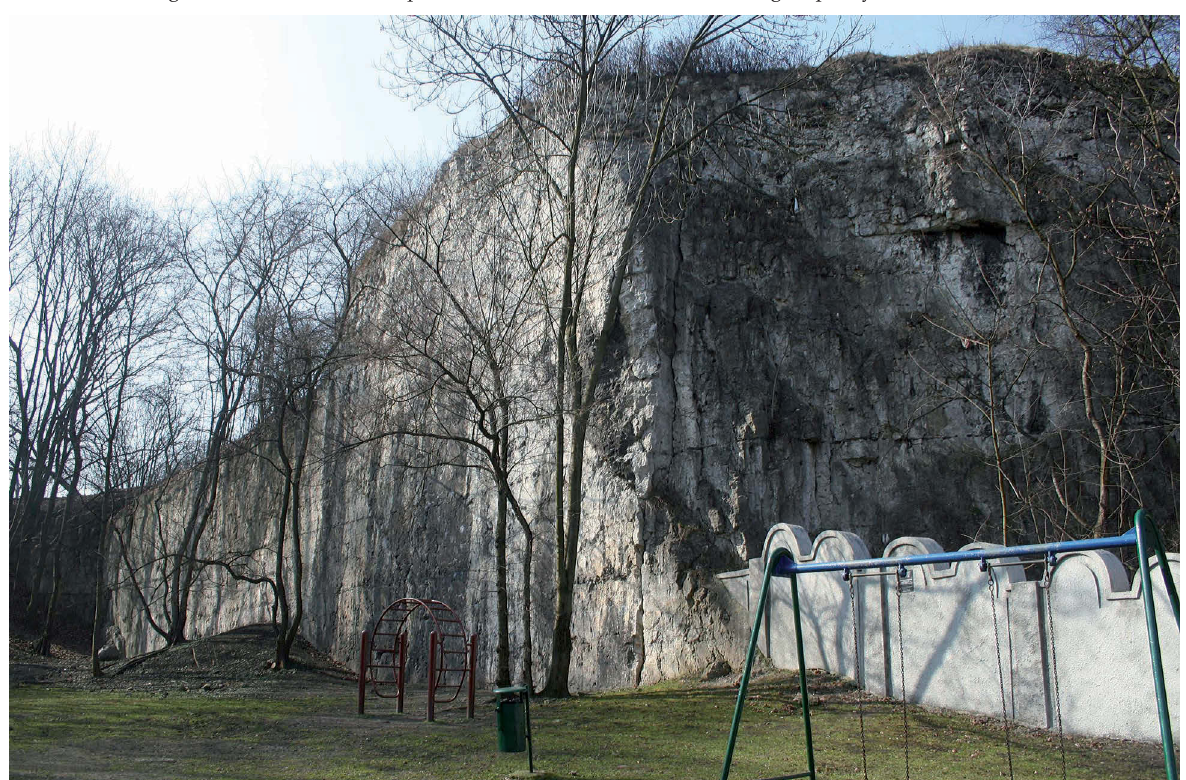
Fig. 9. Recultivated landscape in the area of “Szkoła Twardowskiego” quarry – Bednarski Park